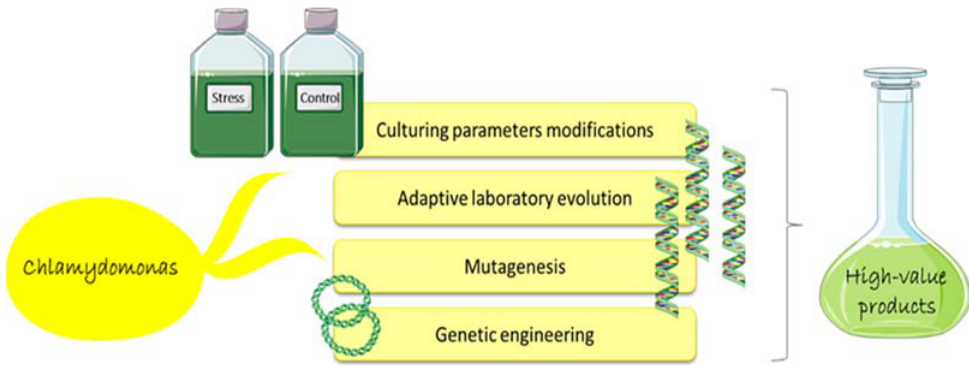
Figure 2. Schematic representations of possible techniques (from modification of the culturing param ‐ eters to adaptive laboratory evolution, mutagenesis, and genetic engineering) used for Chlamydomonas spp. in order to increase the production of products of interest (i.e., high ‐ value products). Hounslow et al. [18,110] studied the effects of salt stress (0.1, 0.2, 0.3 M of NaCl) on a C. reinhardtii low ‐ starch strain, showing a lipid concentration increase, even after long ‐ term exposure to 0.1 M of NaCl or short ‐ term to 0.2 and 0.3 M of NaCl, demonstrating how salt stress can trigger lipid production and suggesting this strategy to produce lipids for bio ‐ diesel. Nevertheless, general results on Chlamydomonas spp. indicated that more “robust” and halotolerant species may be more suitable for biofuel ‐ directed lipid production [18]. Kato et al. [111] confirmed that high salinity stress induced lipid accumulation in a halotoler ‐ ant Chlamydomonas sp. The Antarctic ice microalga Chlamydomonas sp. ICE ‐ L, known to be highly resistant to salt stress, was studied by An et al. [17] as possible alternative species for the production of microalgal oil. NaCl stress effects were evaluated on algal growth and oil yield. In addition, considering that the regulation of lipid biosynthesis in microalgae is a cru ‐ cial strategy for resistance to salt stress, expression of five fatty acid desaturase genes was also evaluated: stearoyl ‐ ACP ‐ desaturase ( Δ 9ACPFAD ), Δ 6 fatty acid desaturase ( Δ 6FAD ), endoplasmic reticulum ω ‐ 3 fatty acid desaturase ( ω 3FAD1 ), chloroplast ω 6 fatty acid de ‐ saturase ( Δ 12FAD ), and chloroplast ω ‐ 3 fatty acid desaturase ( ω 3FAD2 ). Authors observed that algal growth rate decreased with the gradual increase in NaCl concentration, and the highest lipid content was achieved at 16‰ NaCl (C18:3 was the dominant PUFA). At the gene level, Δ 9ACPCiFAD was the most up ‐ regulated in response to altered salt stress, while Δ 12CiFAD , ω 3CiFAD2, and Δ 6CiFAD showed a delayed expression increase. Ho et al. [14] studied the combined effects of salinity and nitrogen depletion stress exposure on lipid ac ‐ cumulation in a newly isolated marine microalga, namely Chlamydomonas sp. JSC4. A new cultivation strategy (denoted salinity ‐ gradient operation) was also used in order to increase lipid accumulation reaching an optimal lipid productivity of 223.2 mg L − 1 d − 1 and a lipid content of 59.4% per dry cell weight. Authors highlighted that this performance was signif ‐ icantly higher than those reported in most related studies and showed that the combination of biological and engineering technologies helped to effectively enhance oil production. Another approach, named adaptive laboratory evolution (ALE), used a long ‐ term cul ‐ tivation of species under selective conditions in order to improve phenotypes by spontane ‐ ous mutations [112]. ALE aims to improve the stress tolerance of microalgae and at the same time enhance the production of high value ‐ added products (such as lipids and carotenoids).